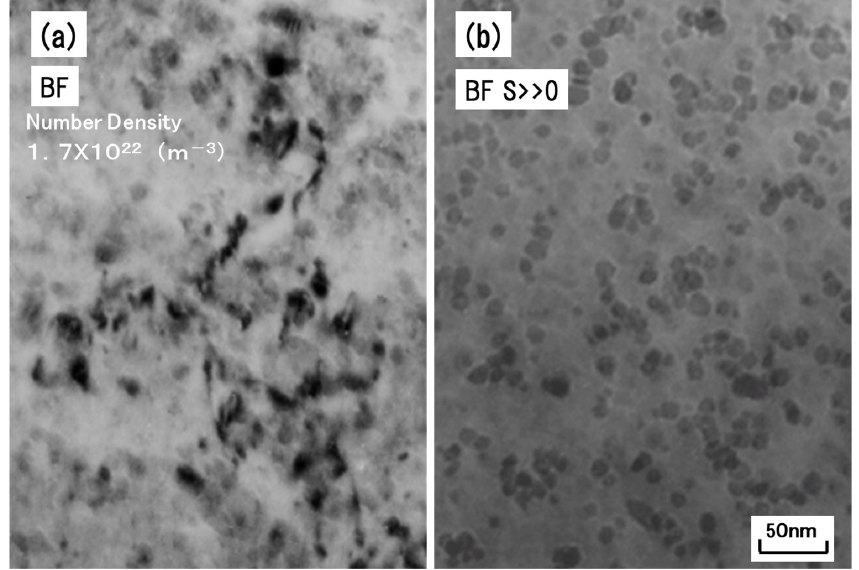
Figure 5. Images from CRPs using different Bragg conditions; ( a ) S ~ 0, ( b ) S >> 0. S is a variation from Bragg condition. Dislocation and dislocation loops are only visible in the case of S ~ 0.